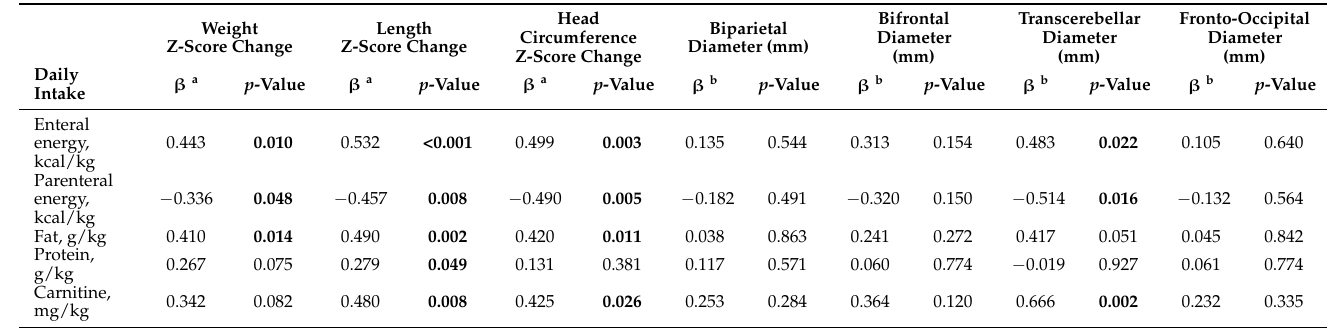
transcerebellar diameter ( β = 0.483, β = 0.666, and β = –0.514, respectively; p < 0.05 for all). Table 3. Associations of daily enteral and parenteral energy, macronutrient, and carnitine intakes (mean of weeks 1 and 5) with postnatal weight, length, and head circumference Z-score change from birth to term equivalent age (TEA) and brain size at TEA (linear regression model).